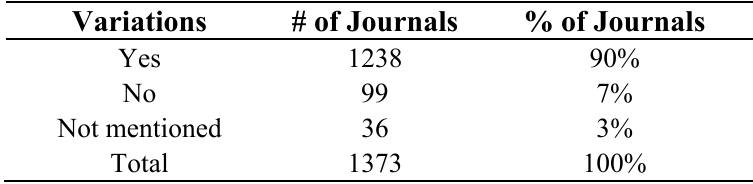
Table 6. Percentage of journals offering variations in